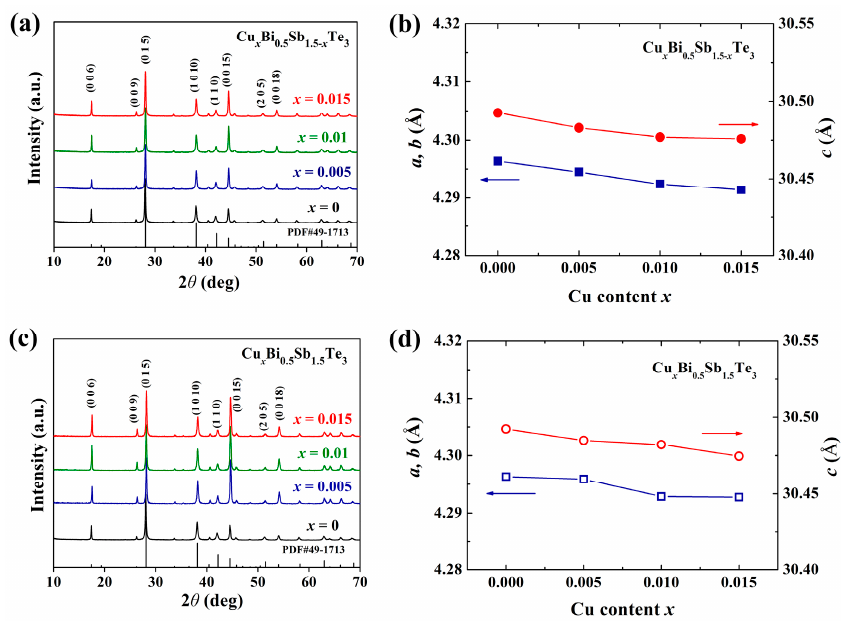
Figure 1. ( a ) X-ray diffraction patterns and ( b ) refined lattice parameters for nominal Cu-doped Cu x Bi 0.5 Sb 1.5- x Te 3 ( x = 0, 0.005, 0.01, 0.015) samples; ( c ) X-ray diffraction patterns and ( d ) refined lattice parameters for nominal Cu-intercalating Cu x Bi 0.5 Sb 1.5 Te 3 ( x = 0, 0.005, 0.01, 0.015) samples.